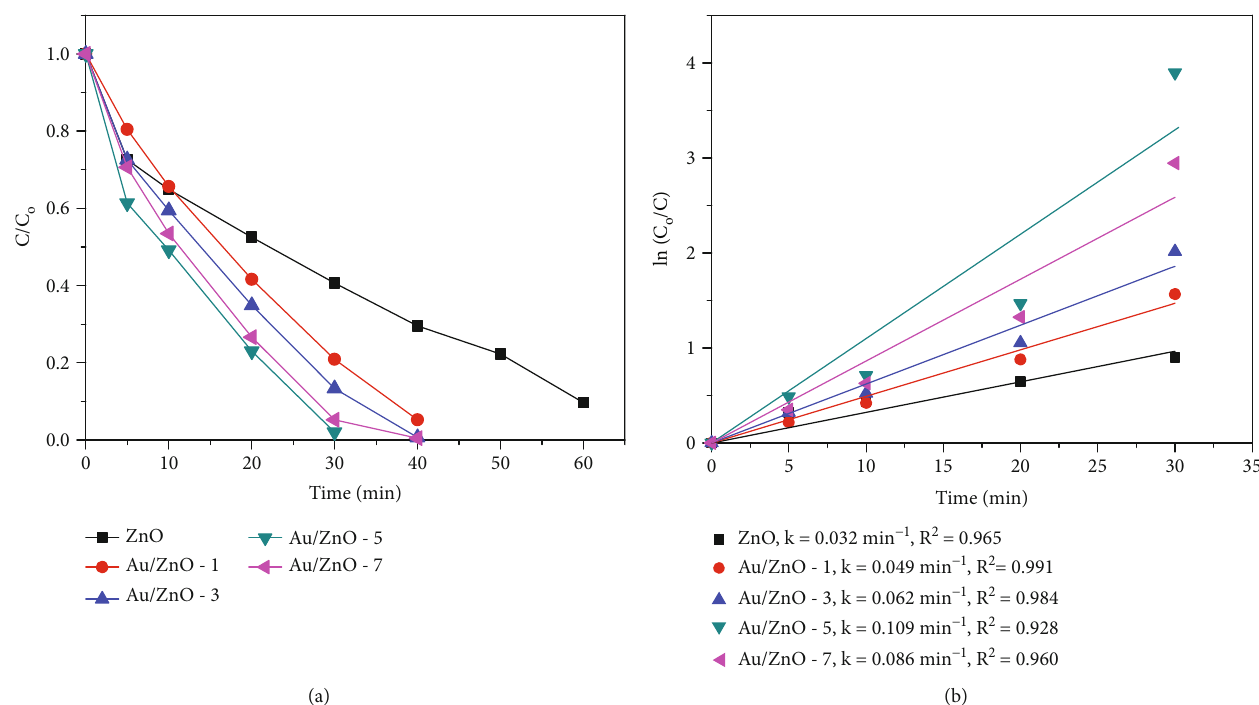
Figure 8: (a) Photocatalytic degradation of TA in ZnO and Au/ZnO composites at the di ff erent Au contents and (b) the kinetic curves. The reaction conditions: TA concentration of 10 mg/L, catalyst dosage of 0.5g/L, pH solution of 6.0, and Hg lamp